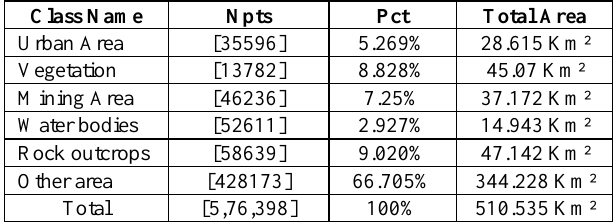
Table 5. Land cover/land use classes and area (1990)